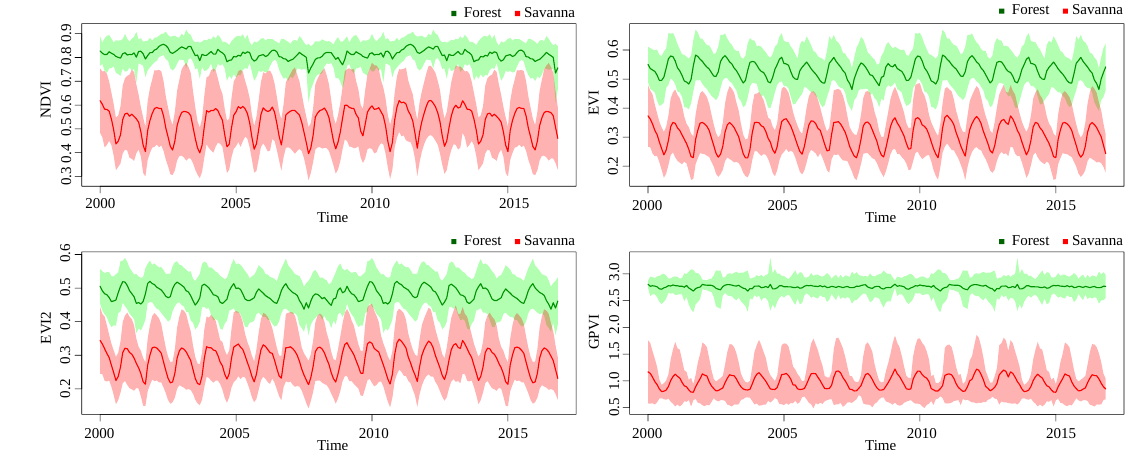
Figure 8. Time series for forest/savanna discrimination (Landsat). Shaded areas indicate the standard deviation of the index scores among all the data points for a given timestamp.